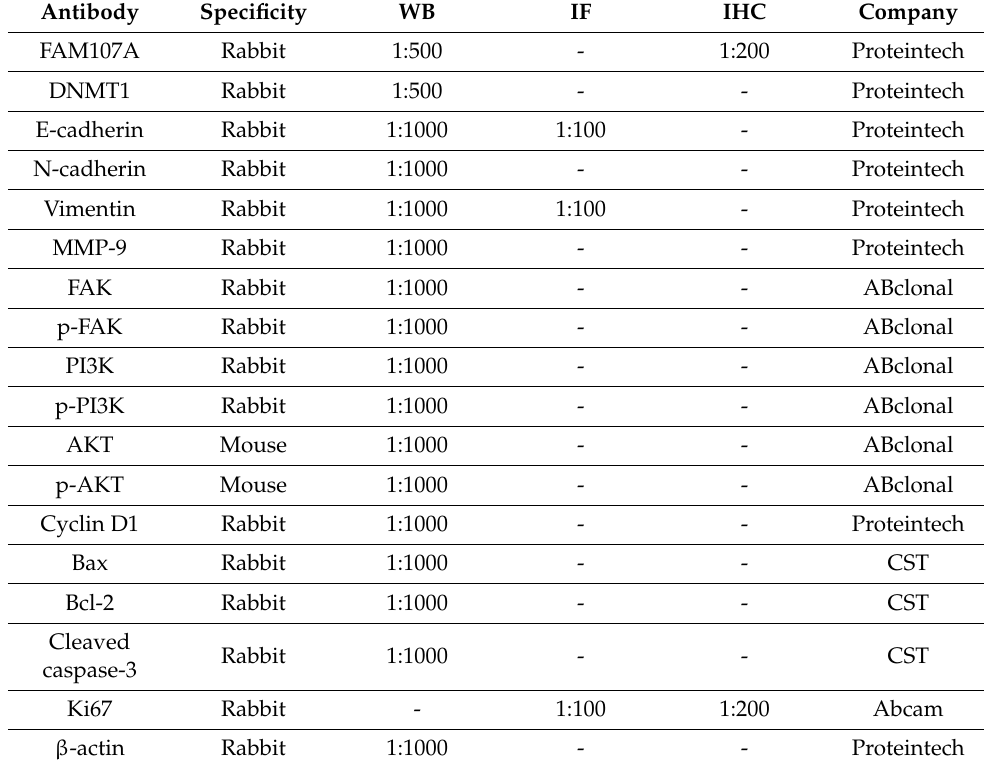
Table 1. Primary antibodies used in this